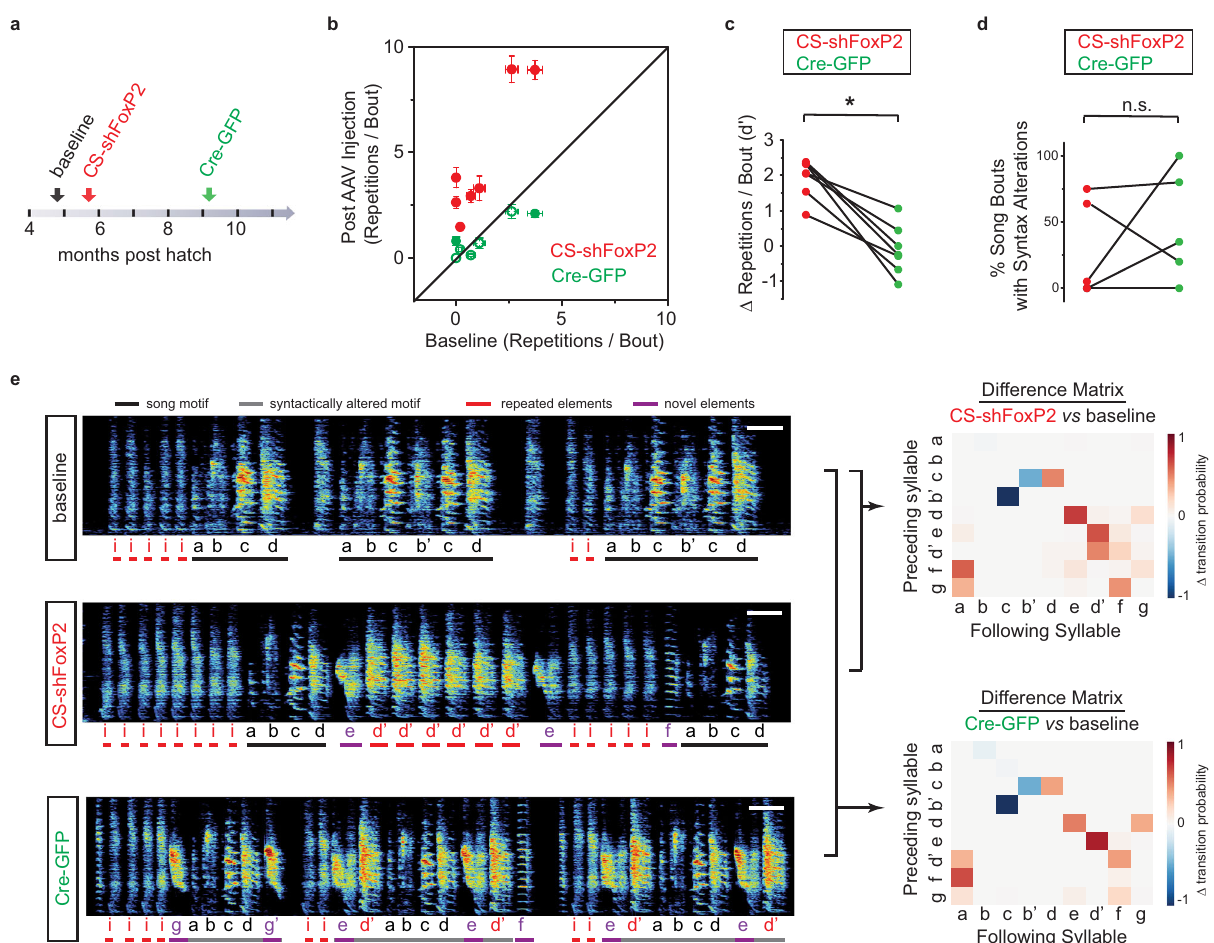
Fig. 3 Reversal of FoxP2 knockdown in adult zebra fi nches rescues vocal repetitions but not disruptions in song syntax. a Strategy for FoxP2 rescue in Area X. b Comparison of the number of syllable repetitions per song bout (mean ± SEM) at baseline versus 2 months after injection of CS-shFoxP2 or Cre- GFP ( n = 5 birds). Red fi lled circles represent vocal elements with signi fi cant differences between baseline and post CS-shFoxP2 injection ( p < 0.0001 and p = 0.012, Kruskal – Wallis test); green open circles, vocal elements with nonsigni fi cant differences ( p > 0.2, Kruskal – Wallis test); green fi lled circles, vocal elements with signi fi cant differences ( p = 0.014 and p = 0.027, Kruskal – Wallis test) between baseline and post Cre-GFP injection. The number of